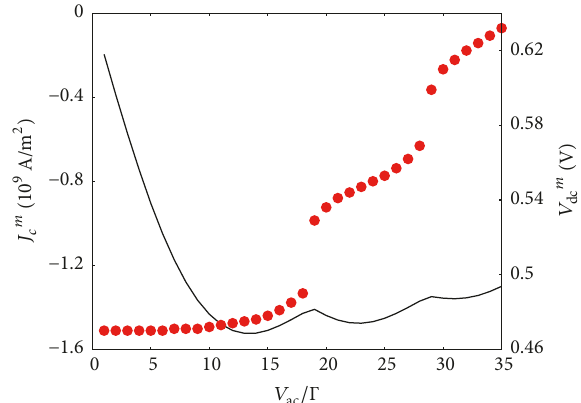
Figure 10: Maximum absolute value of the negative active current 𝐽 𝑐𝑚 (solid line, left 𝑦 axis) and operating point position (red circles, right 𝑦 axis) as a function of amplitude of the AC electric field at the frequency ℏ𝜔 = 4Γ for RTD heterostructure number